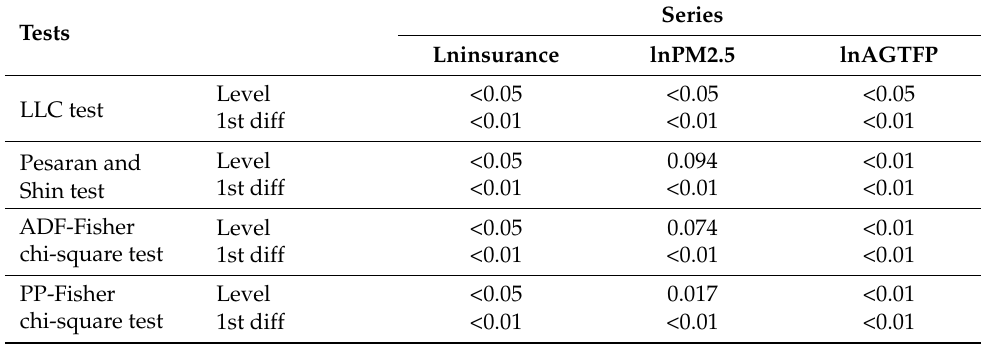
Table 3. The LLC, IPS, ADF Fisher and PP Fisher chi squared